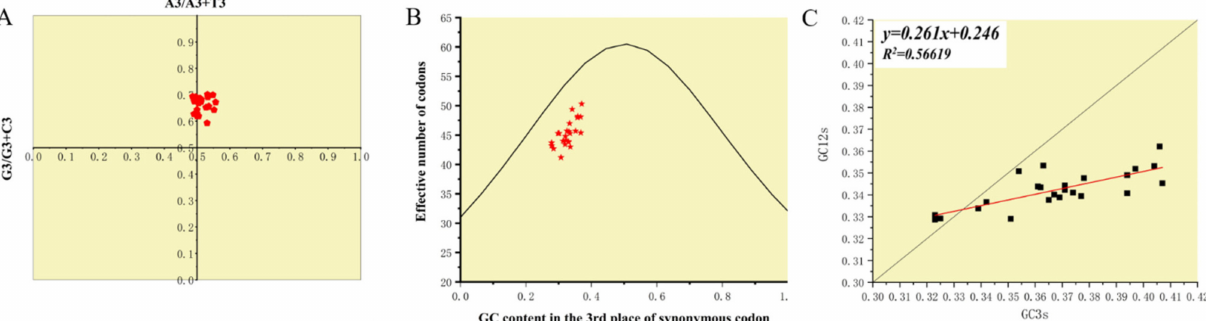
Figure 8. Analysis of factors mediating codon usage bias. ( A ) Parity Rule 2 (PR2) plot was used to analyze whether the effects of mutation pressure and natural selection on the use of the Rep codon were consistent. Figure 8A shows that mutation pressure and natural selection have unequal effects on the use of codons during evolution. ( B ) The ENC-GC3s plot was analyzed, with the ENC values plotted against the GC3S values to determine the main factors affecting codon use bias. The expected ENC values for each GC3S were estimated. Figure 8B shows that main factor affecting codon use bias was selection pressure. ( C ) Neutrality analysis was used to evaluate the effects of mutation pressure and natural selection on codon usage patterns. Figure 8C shows that the fitting curve (red line) deviates from the curve y = x (black line), indicating that selection pressure plays a dominant role, which is consistent with Figure